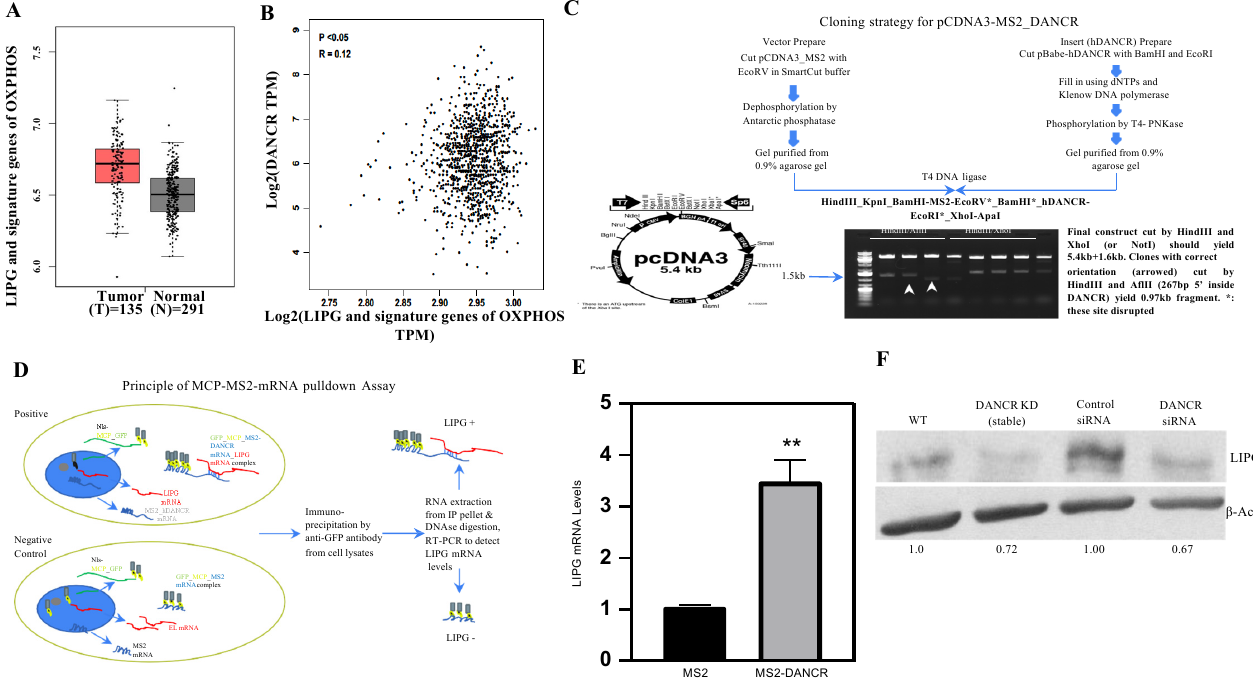
Figure 1. DANCR mediates LIPG expression. ( A ) LIPG and signature genes of OXPHOS in tumor and normal tissues. ( B ) Analysis of correlation between DANCR and LIPG plus signature genes of OXPHOS from IBC tumors. The Pearson method was used for analysis. Correlation is statistically significant ( p < 0.05). TPM: transcripts per million. ( C ) Cloning strategy for pCDNA3-MS2_DANCR. ( D ) The principle of MCP-MS2-mRNA pulldown assay. ( E ) stable LIPG-overexpressing MDA-MB-468 cells were co-transfected with p_NLS_MCP_GFP and pCDNA3-MS2 (negative control) or pCDNA3- MS2_hDANCR. Cells were collected 48 h after transfection for RNA pulldown assay using anti-GFP antibody. RNA was extracted for qRT-PCR. The expression levels were presented as fold changes compared to MS2 control. ** p < 0.01. ( F ) MDA-MB-468 cells were transfected with shRNA DANCR or siRNA DANCR, and protein levels of LIPG were measured by Western blot, the uncropped blots are shown in Figure